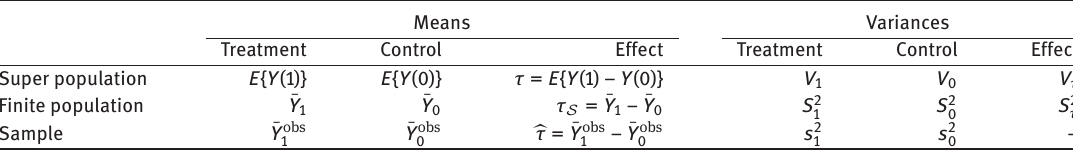
Table 1: Means and variances at the super population, finite population and sample levels. Means Variances Treatment Control Effect